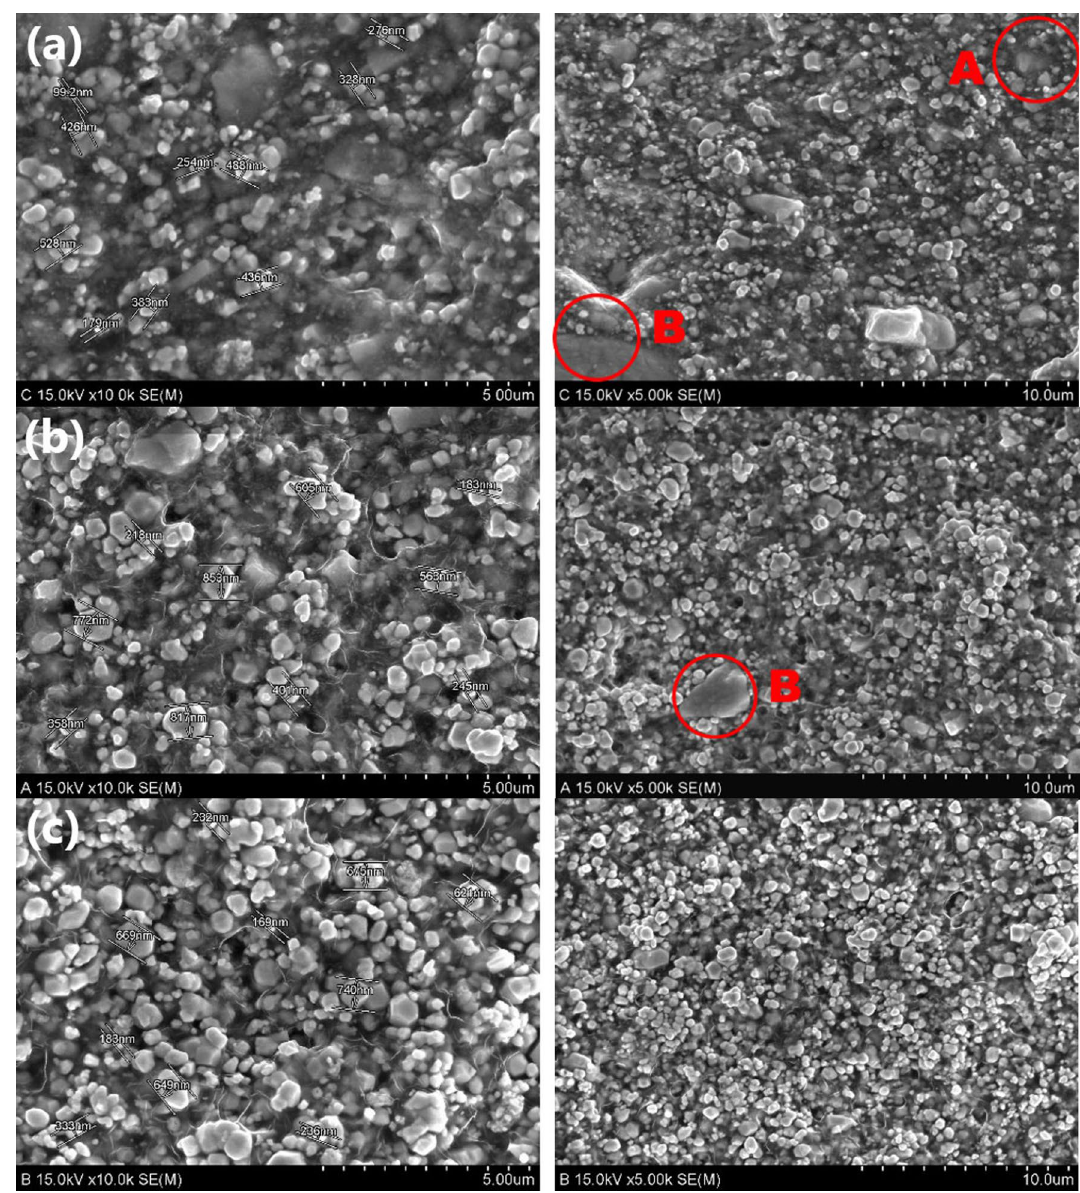
Figure 2. Comparison of images of tungsten particle distribution on shielding film cross-sections subjected to different dispersion methods. ( a ) Tungsten nanoparticles distribution on single-sided dispersion method shielding film (SSF). ( b ) Tungsten nanoparticles distribution on double-dispersion method shielding film (DSF). ( c ) Tungsten nanoparticles distribution on air pressure mirroring particle dispersion method shielding film